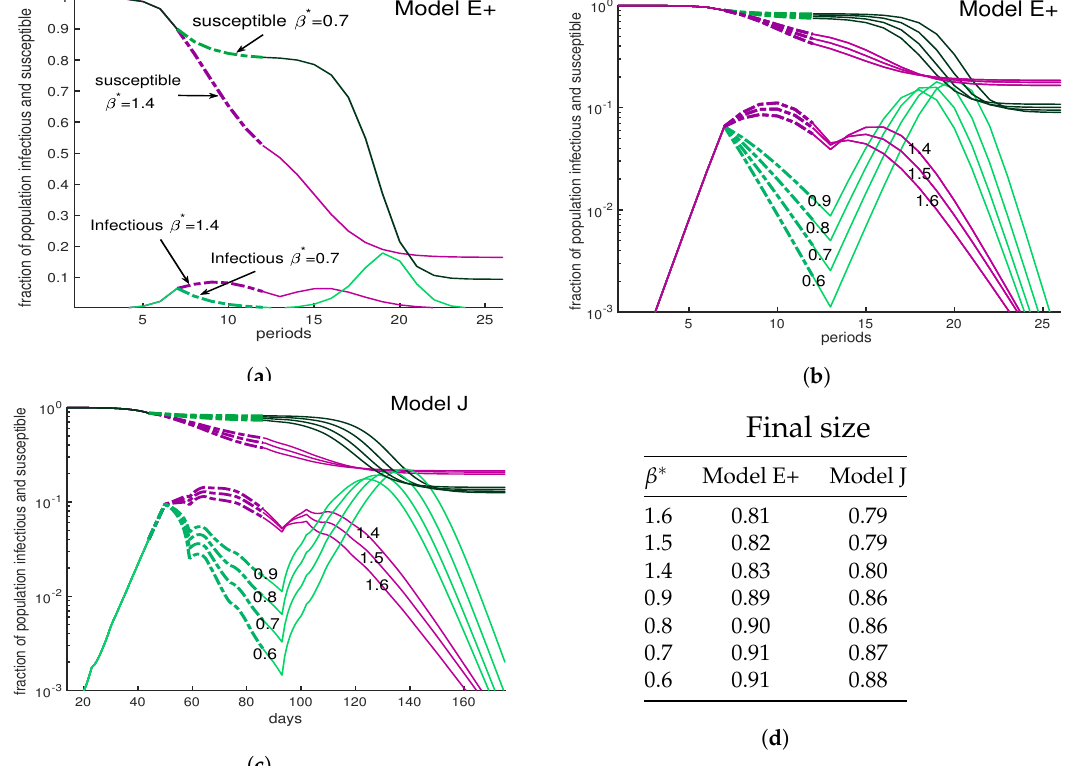
Figure 8. A severe intervention is more likely than a mild intervention to be followed by a large peak. Outside the intervention period, β = 3. During intervention the contact rate is shown by β ∗ . The curves are dashed during the intervention period. ( a ) This figure compares a mild intervention with a strong intervention using Model E+. The uncontrolled outbreak with no intervention (not shown) has a peak about 28% and S final ∼ 6%; i.e., 94% of the population is infected during the entire outbreak. Mild intervention, β ∗ = 1.6, raises S final to ∼ 25%. The severe intervention raises the S final to ∼ 18%. ( b , c ). We show an outbreak with a 6-week intervention with a variety of contact rates for both Model E+ (panel b) and Model J (panel c). The intervention period begins when the susceptible population S ( d ) is ≈ 0.9. The vertical axis is showing the fraction of the population susceptible (upper curves) in week n for Model E+ or in day d for Model J. The lower curves are I n for Model E+ and Infec ( d ) for Model J. Mild interventions (magenta) reduce β to 1.4 to 1.6 and severe ones (green) reduce β to 0.6 to 0.9. Model J changes β by changing J β using Equation (13). For Model J, exposed individuals are infectious on days 7 through 12 and they are equally infectious. ( d ) The final sizes are shown for both Model E+ and Model J. The final size is the total fraction infected during the entire outbreak. According to the table in ( d ), the strong intervention results in more infected cases during the entire outbreak than the mild